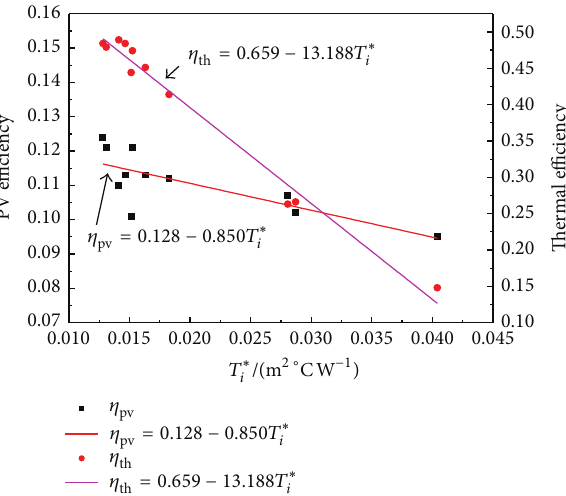
Figure 7: PV efficiency and thermal efficiency fit curves of the experimental results on SPV/T